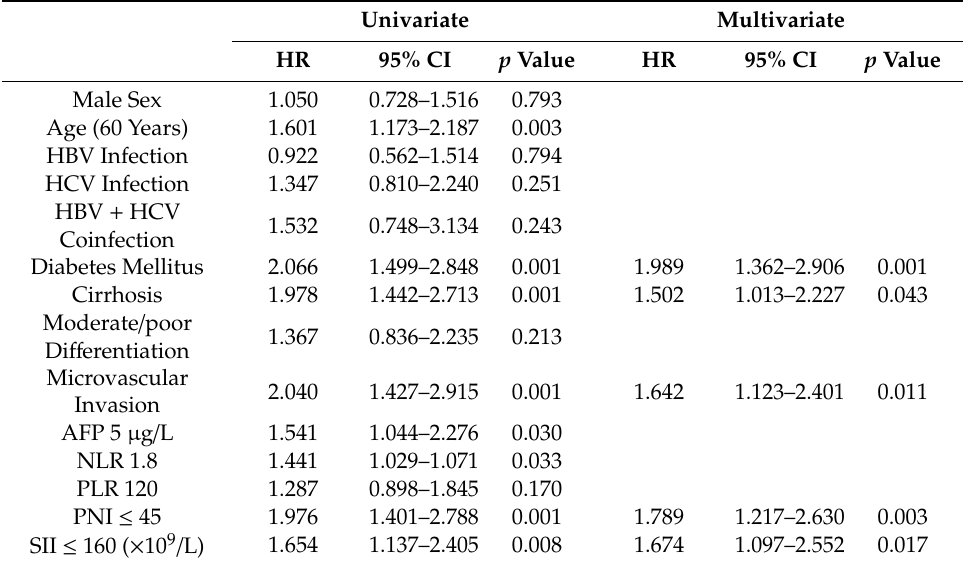
Table 4. Uni-and multivariate analyses of factors associated with mortality by Cox proportional hazards